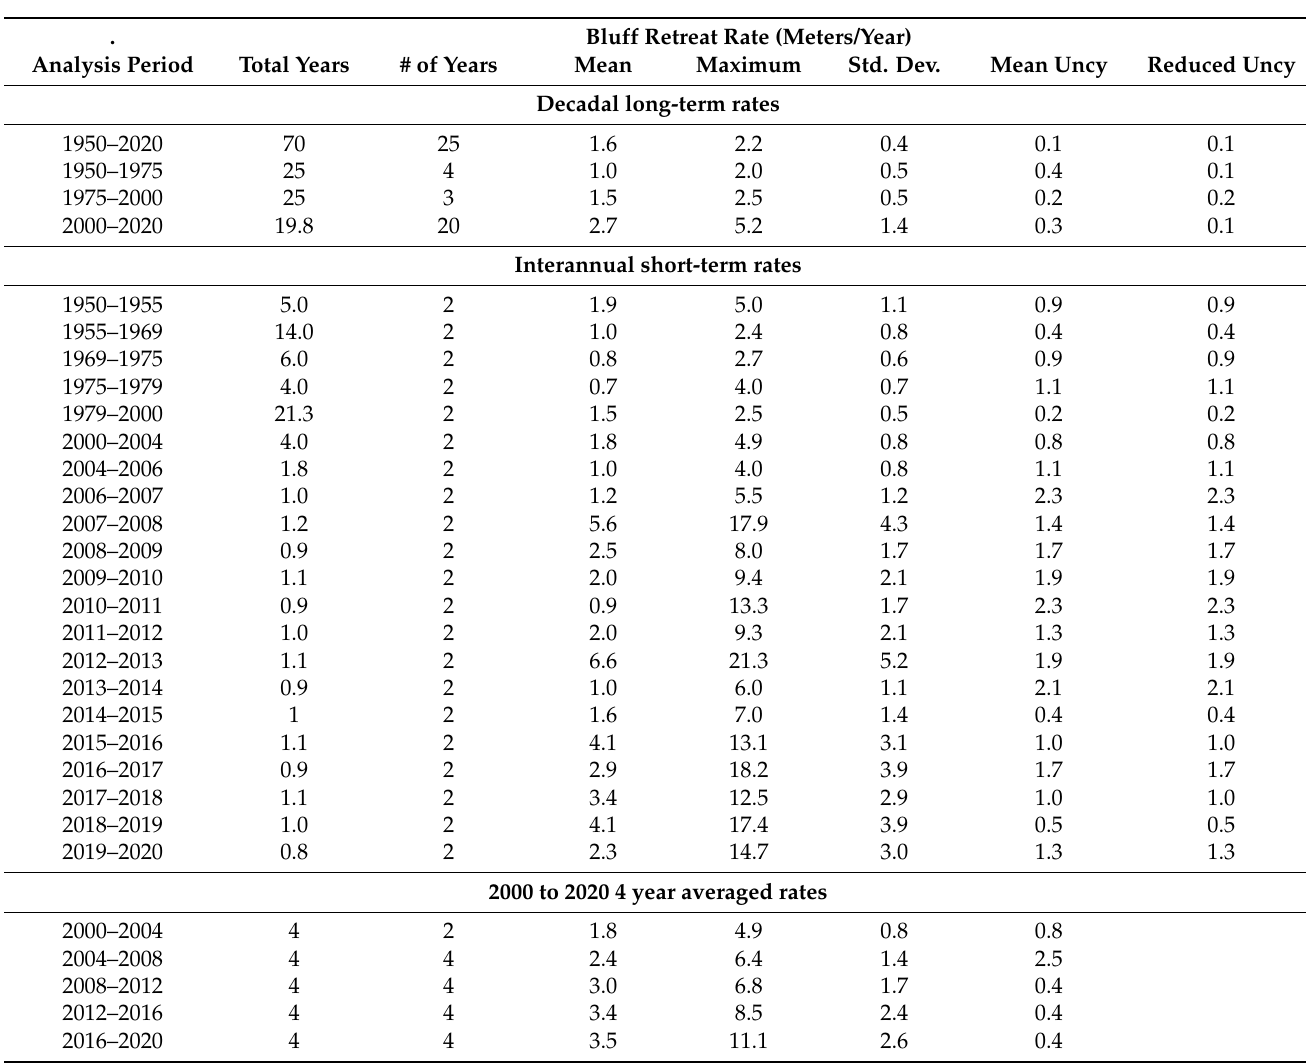
Table 2. Barter Island bluff retreat